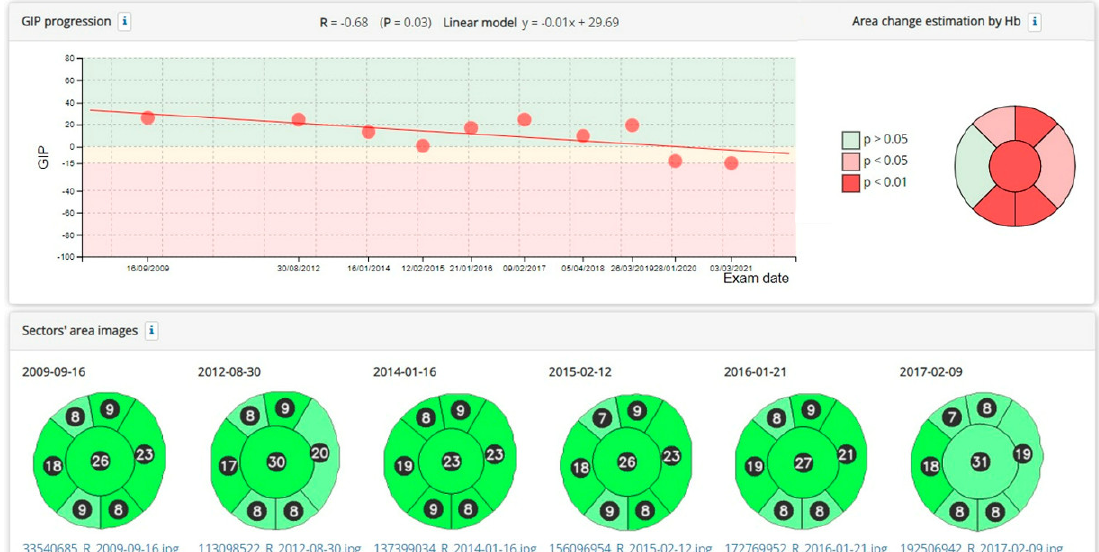
Figure 4. Example of a significant reduction in the GIP index over several years. A significant increase in the percentage area of the cup and a reduction in several sectors of the rim is also observed. The change from dark green to light green in the optical disc sectors indicates that the haemoglobin density, compared to the normal population, has decreased from a value above the normal median to a value below the median. Table 1. Cases with significant progression ( p < 0.01). The percentage of cases that progressed, the slope per year of the GIP index, and the percentage area of the cup in relation to the number of control examinations performed are